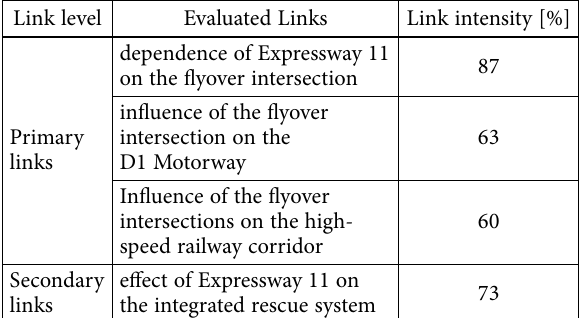
Figure 6. Structural map of the spread of cascading impacts in the event of a flyover intersection collapse